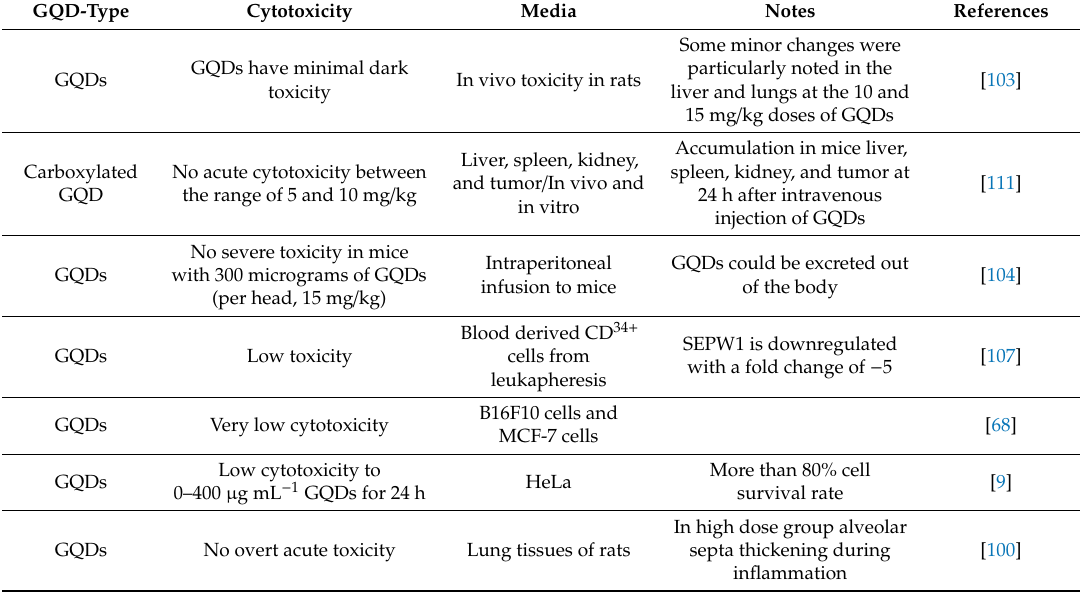
Table 2. GQDs and their cytotoxic e ff